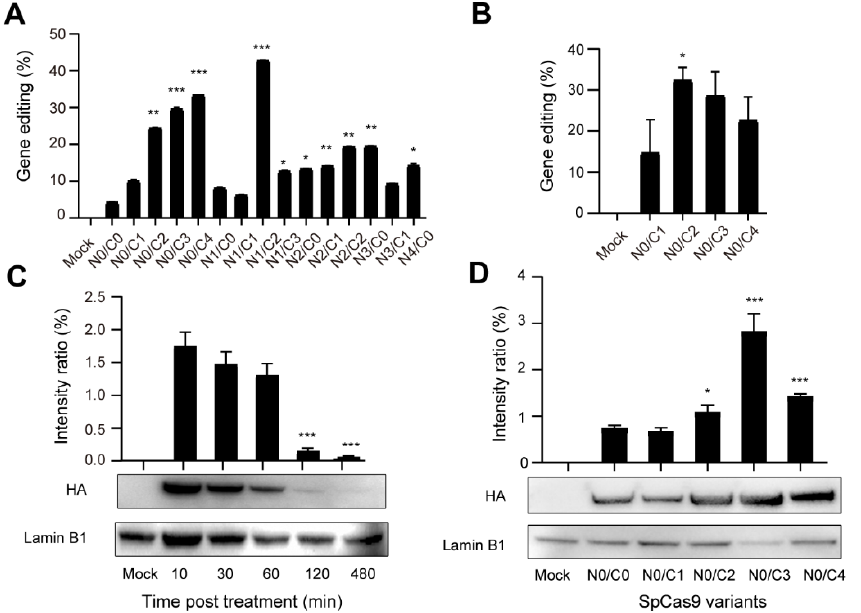
Figure 3. Evaluation of the genome-editing activity of nucleofected multi-NLS SpCas9 proteins. ( A , B ) Evaluation of the genome-editing activity of multi-NLS SpCas9 at the CCR5 site in K562 ( A ) and Jurkat ( B ) cells. The results are quantified using T7E1 analysis and presented as mean ± SD ( n = 2). The difference between N0/C1 and multi-NLS constructs is analyzed by two-tailed Student’s t test. *, p < 0.05; **, p < 0.01; ***, p < 0.001. The difference between SpCas9 groups and mock group is determined using one-way analysis of variance (ANOVA) with Dunnett’s multiple comparisons test. All SpCas9 groups have P values of less than 0.05 in comparison with mock group. ( C ) Analysis of the retention of nucleofected N0/C1 SpCas9 proteins in K562 cells. The difference between 10 min and other time points is analyzed by two-tailed Student’s t test. ***, p < 0.001. ( D ) Analysis of nucleus localized SpCas9 proteins at 1 h post nucleofection of K562 cells. The difference between N0/C1 and multi-NLS constructs is analyzed by two-tailed Student’s t test. *, p < 0.05; ***, p <